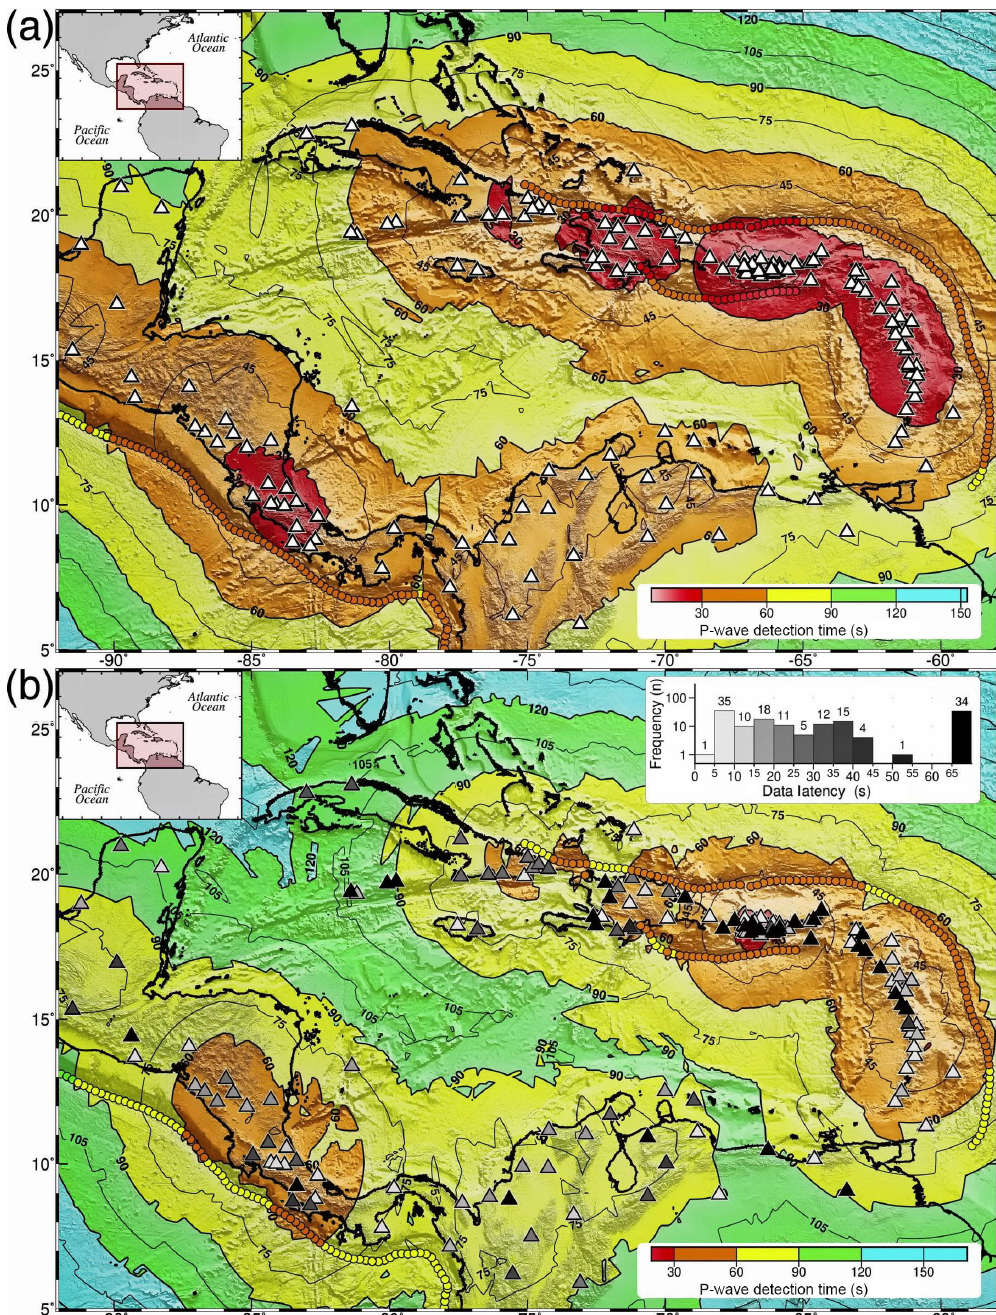
Figure 1. Hypothetical epicenter positions colored by the theoretical detection time of the first arriving P wave within the Caribbean region at a minimum of eight stations, regardless of azimuthal gap after (a) assuming that all seismic stations (white triangles) contribute data with no significant latencies and (b) taking into account the median data latencies and station outages. Station outages at 23% (34 black triangles) of the 146 seismic stations and data latencies longer than 10s for another 52% leave only 25% of the network with latencies under 10s. Consequently, the 90 (yellow), 60 (orange), and 30s (red) detection areas shrink from 83% to 54%, 47% to 14%, and 6.9% to 0.25% of the region, thereby undergoing a 35%, 70%, and 96% reduction in area, respectively. The small, contiguous circles show the computed P wave detection times sampled every 25km along the trench